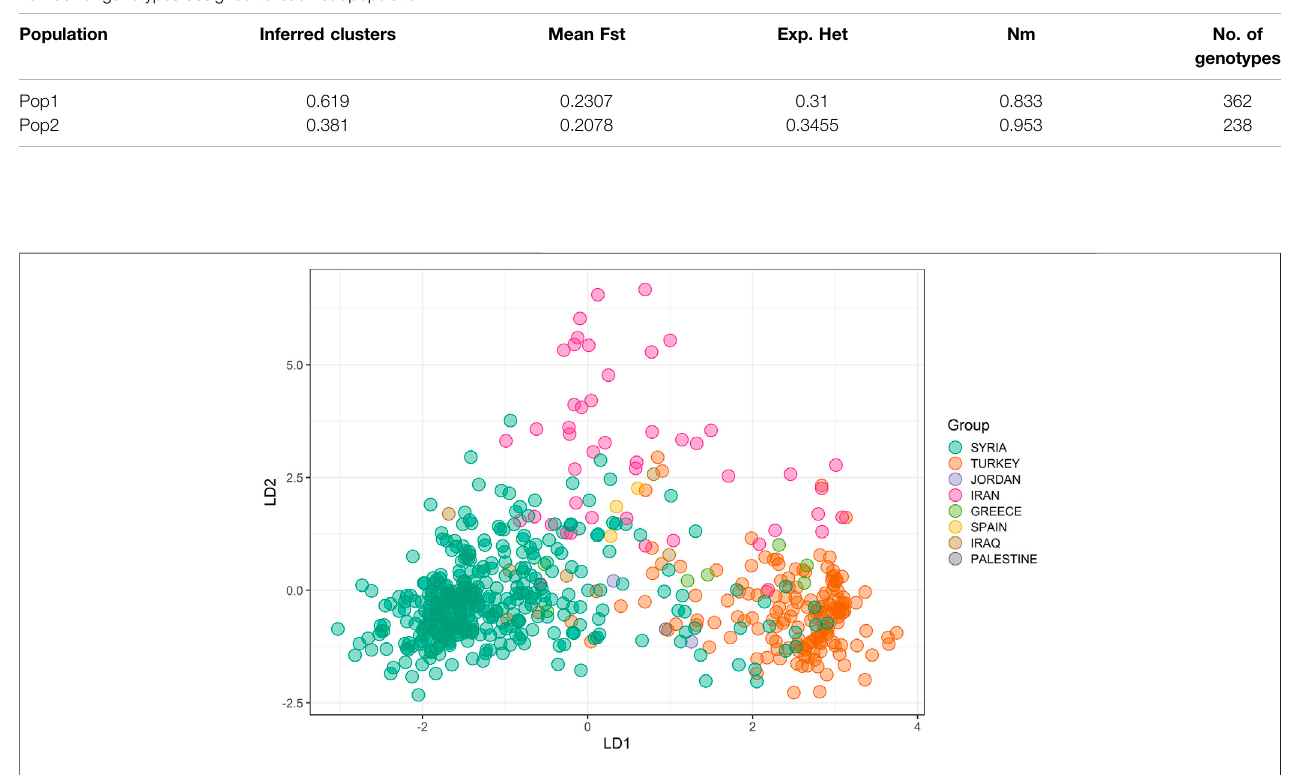
FIGURE 3 | Inference of the subpopulations by DAPC analysis grouping landraces from different countries together.